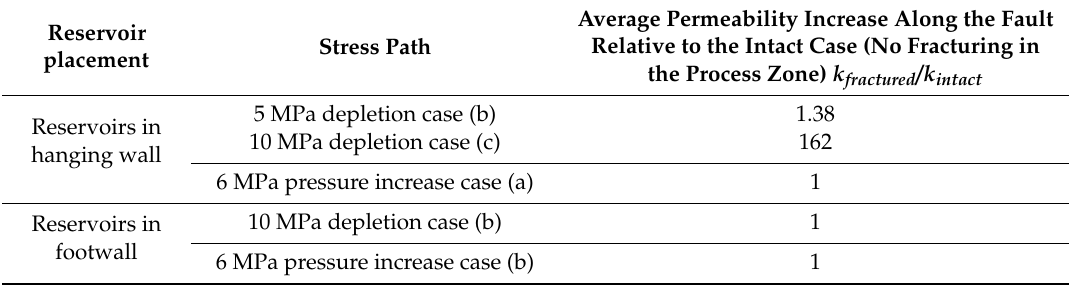
Figure 9. Map of pore pressure distribution after setting a 10 MPa initial pressure difference between the lower and higher reservoir and turning off the fracturing simulator. ( a ) and ( b ) Partial fracturing along the fault’s process zone; ( c ) A leakage path has been established between the two reservoirs; thus the pressure equilibrates in the long-term. Pore pressure in Pa. Table 3. Permeability increase in the fractured process zone relative to the intact case.